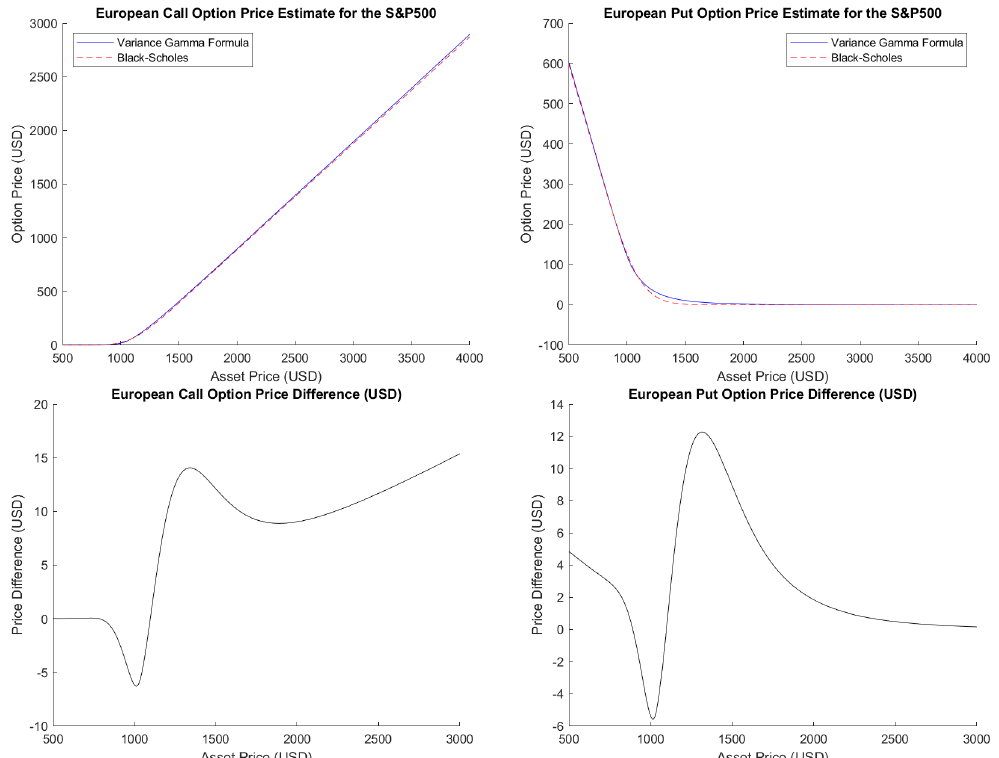
Figure 1. European Options prices under the Black–Scholes and Variance Gamma models and their differences, for K = 1100, τ = 35 × 7/365 and different values of S 0